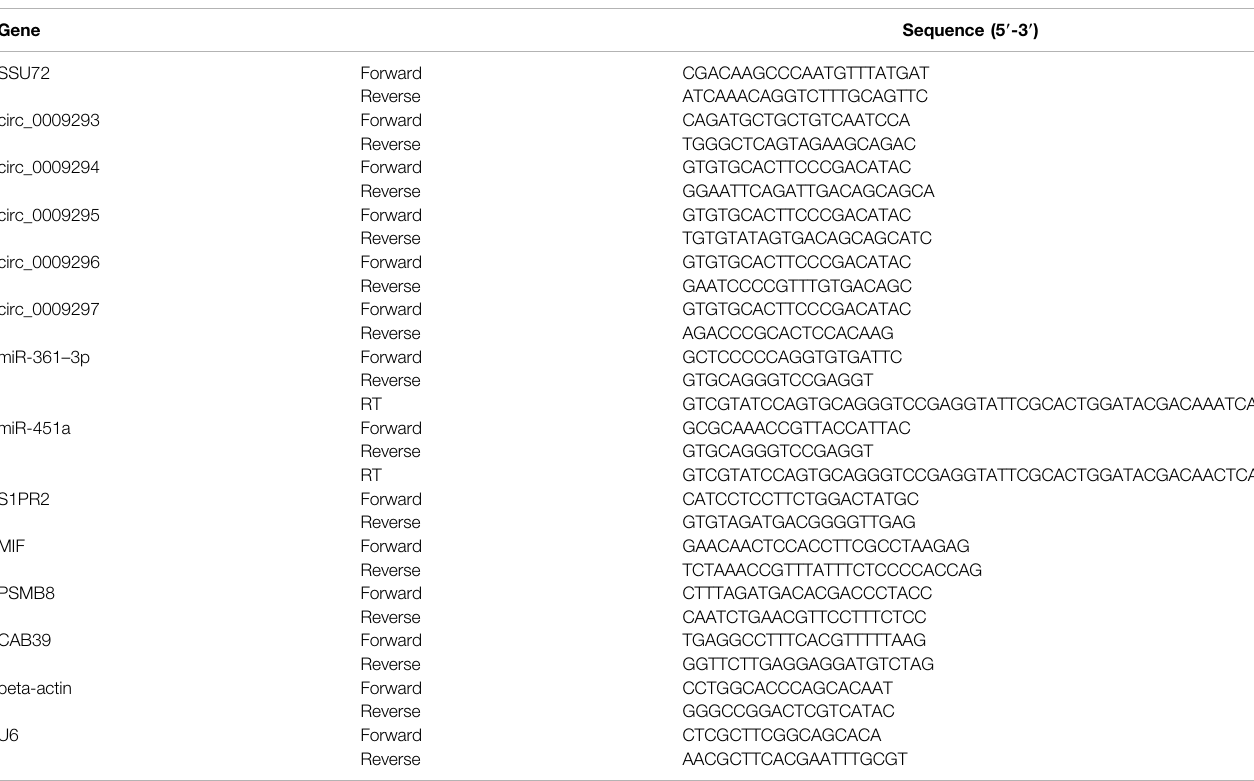
TABLE 1 | The sequence of primers involved in this